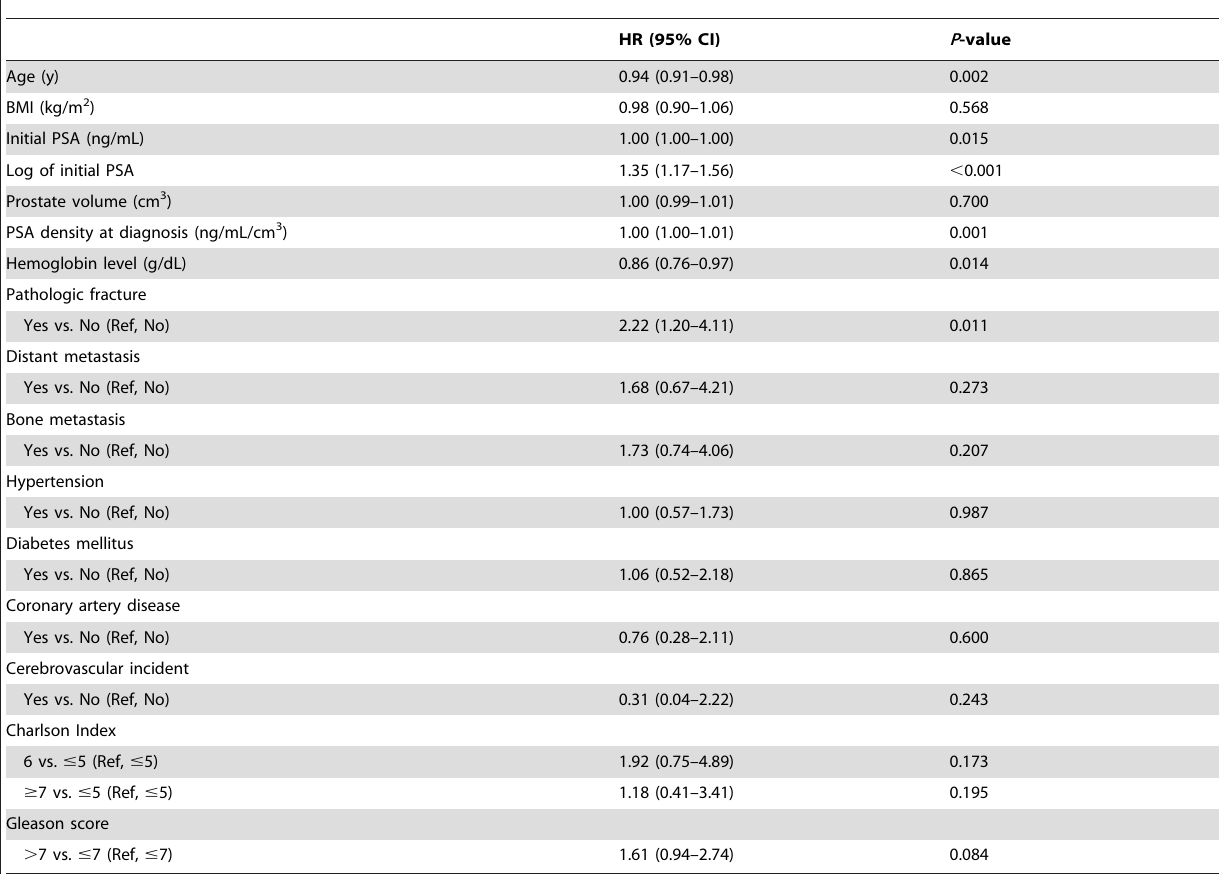
Table 3. Univariate Cox regression analysis for BCP.